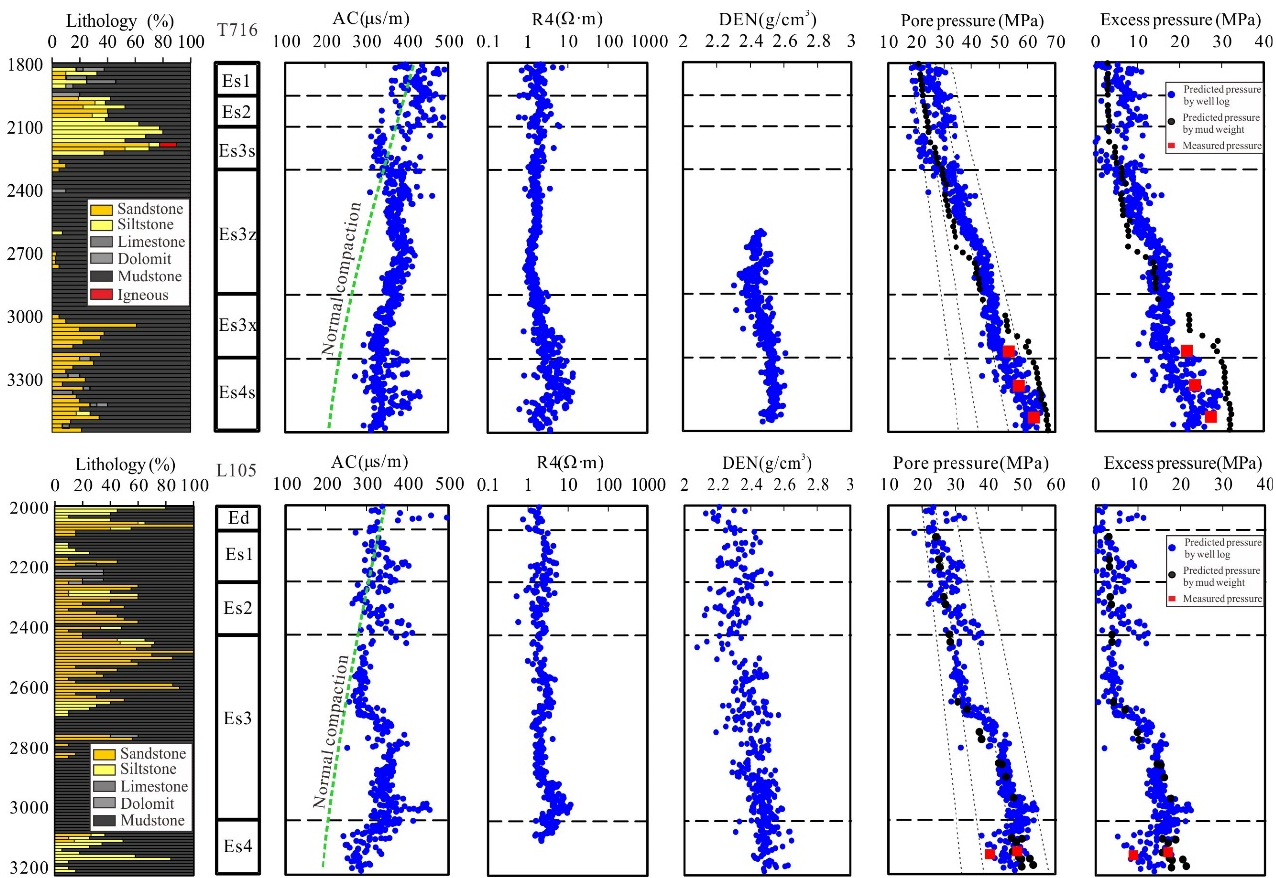
Figure 7. Profiles of acoustic travel time (AC), resistivity log (R4), density log (DEN), fluid pressures, and excess pressures versus depth in Well T716 and Well L105.